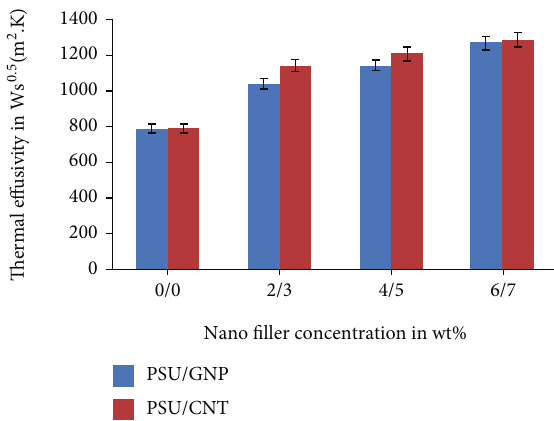
Figure 4: E ff ect of GNP and CNT nano fi ller concentration on thermal e ff usivity of PSU composite.